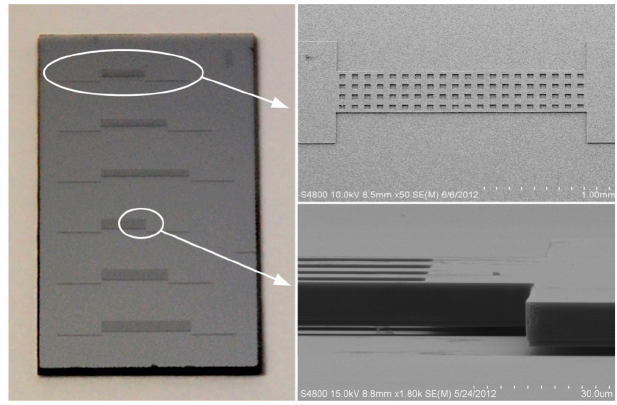
Figure 11. The scanning electron microscope picture of the test sample.